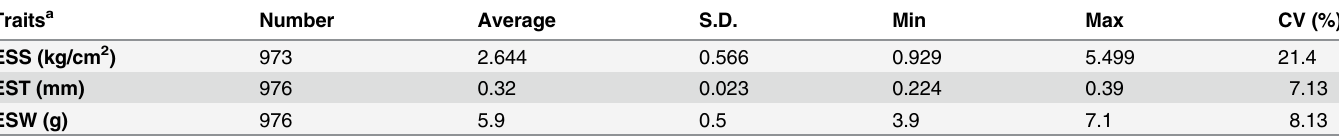
Table 1. Descriptive statistical analysis of eggshell mechanical property.